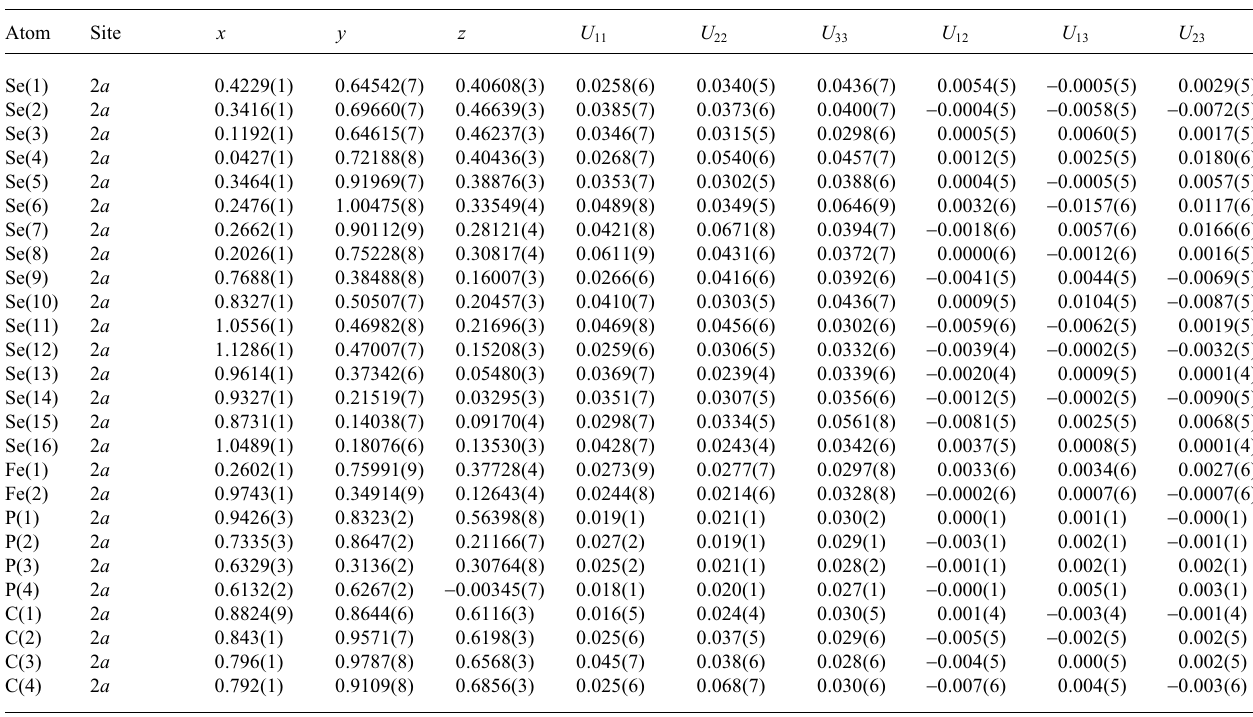
Table 3. Atomic coordinates and displacement parameters (in Å 2 )